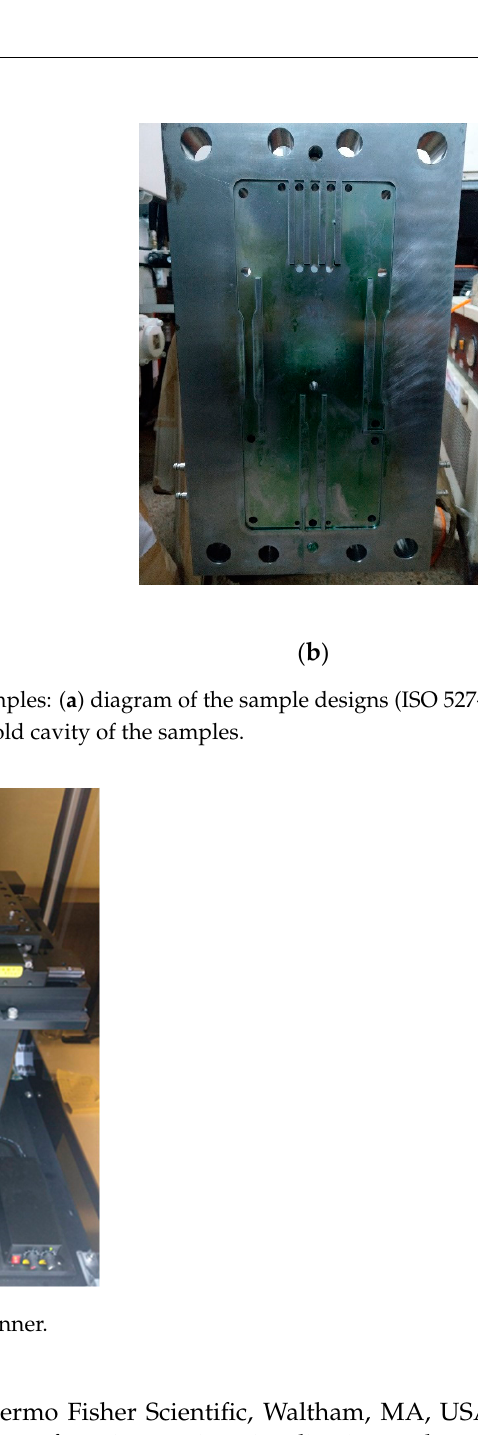
Figure 4. Optical microscopy scanner.